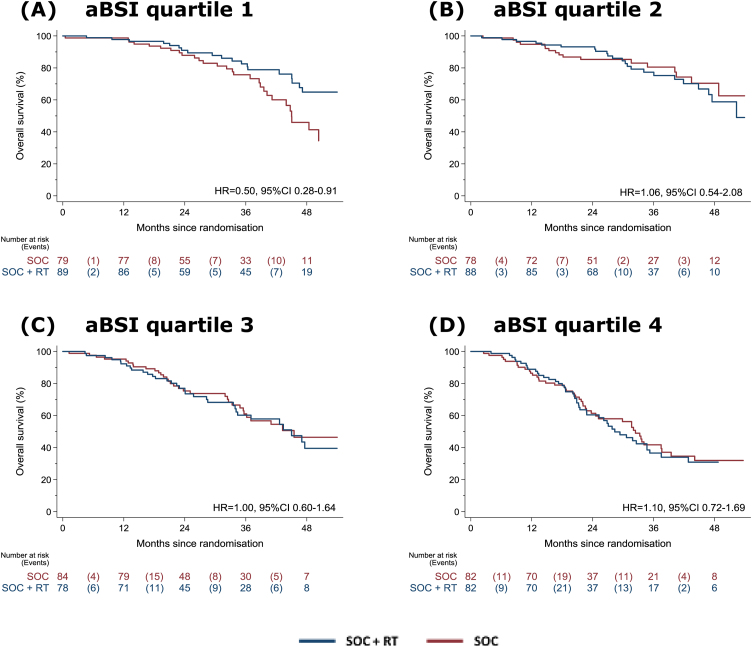
Kaplan-Meier plots for overall survival by treatment in (A–D) aBSI quartiles 1–4. aBSI = automated bone scan index; RT = radiotherapy; SOC = standard of care.